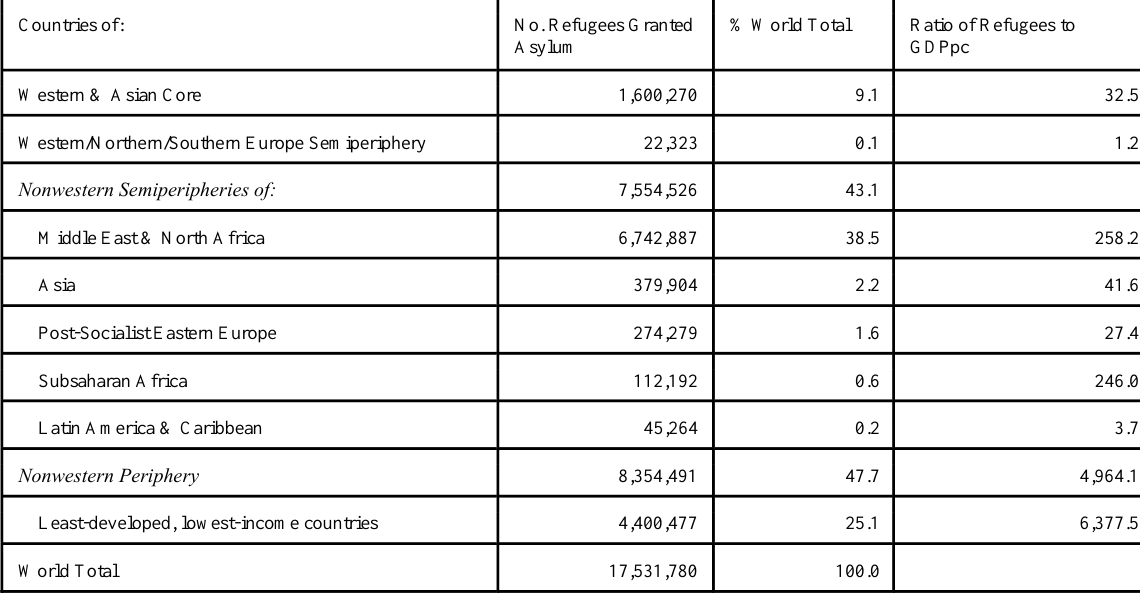
Table 9 . Refugee and Transnational Migration Trends,